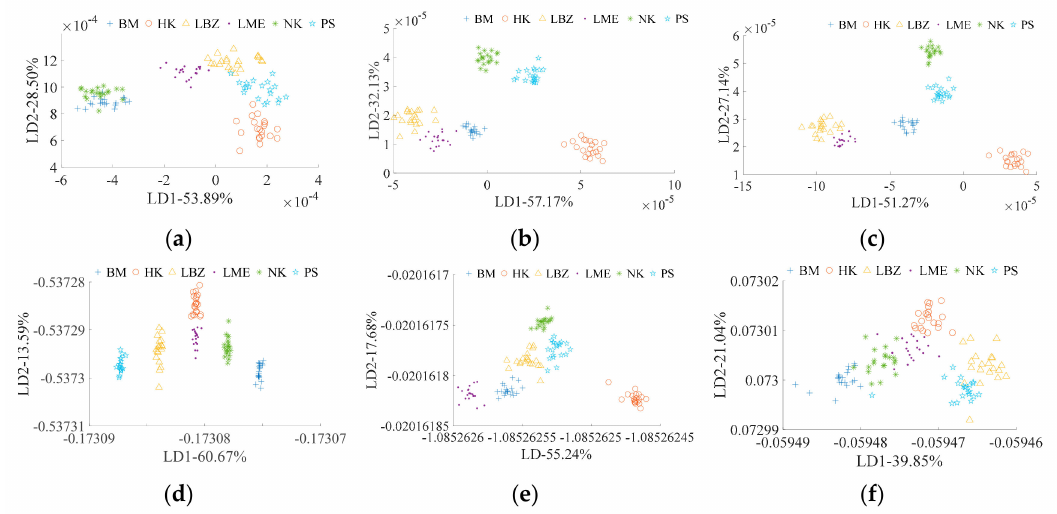
Figure 3. Linear discriminant analysis (LDA) for ancient Pu’er tea discrimination based on E-nose. ( a – c ) are traditional feature extraction; ( d – f ) are CNN feature extraction; ( a , d ) are E-nose detection; ( b , e ) are visible / near Infrared (VIS / NIR) spectrometer detection; and, ( c , f ) are multi-information fusion